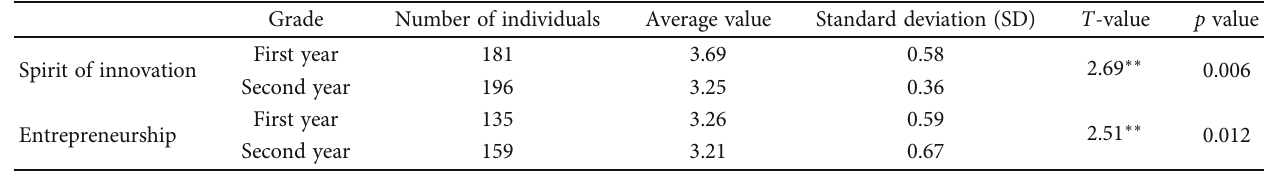
Table 3: Di ff erences in innovative spirit and entrepreneurial ability by grade level